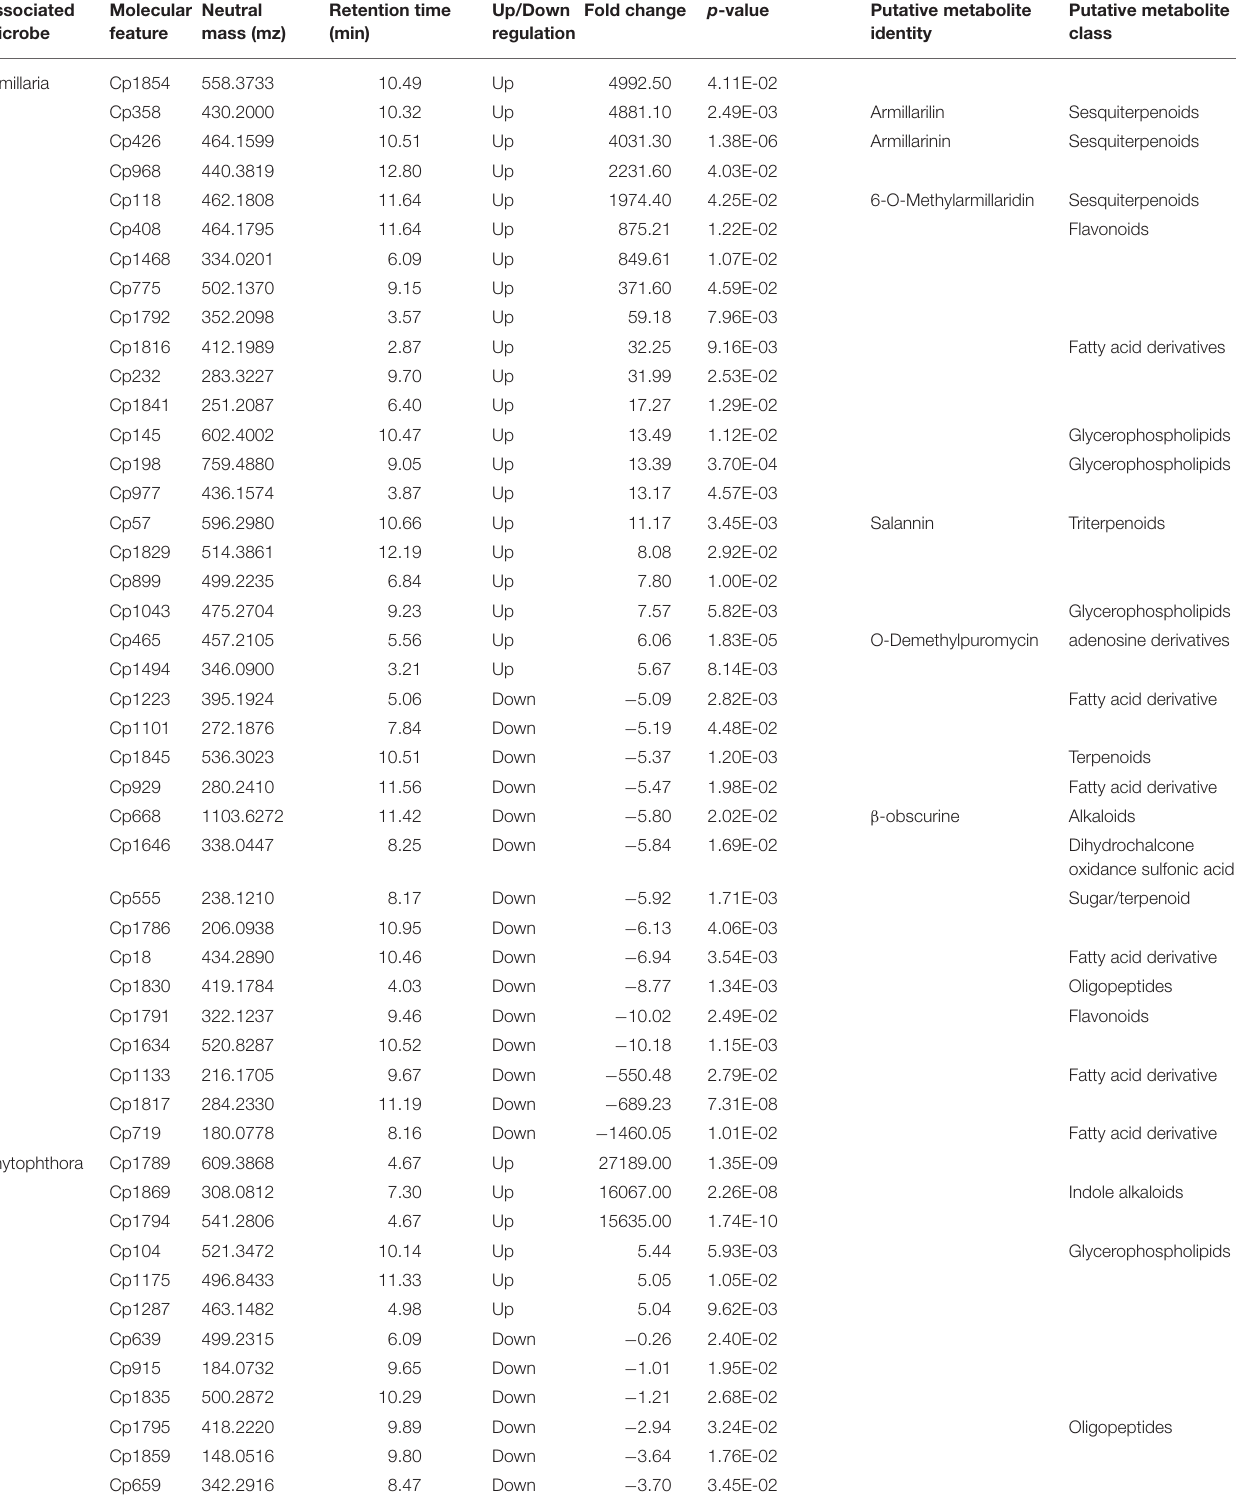
TABLE 2 | Table describing the specifically-regulated molecular features and their putative identities in root tips by different associated microbes (ESI + mode). Associated